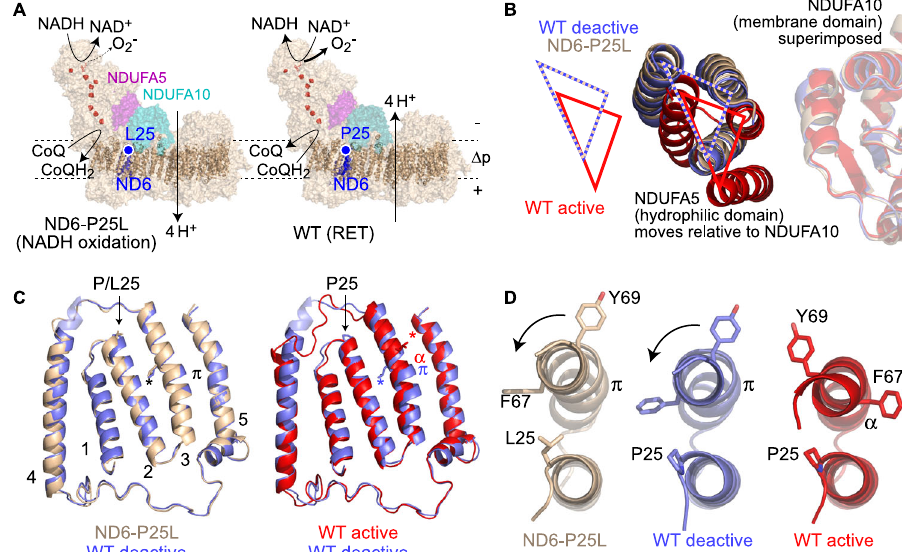
Fig. 1 Structure of complex I containing the ND6-P25L mutation. A The NADH oxidation reaction is shown on the structure of ND6-P25L complex I (left). Complex I oxidizes NADH and reduces CoQ, and pumps four protons out of the mitochondrion to support the proton motive force ( Δ p). The reverse electron transfer (RET) reaction is shown on the structure of WT complex I (right). When Δ p is large and the CoQ pool is highly reduced, electron and proton transfer at complex I are reversed; CoQ is oxidized and NAD + reduced to NADH. Alternatively, the electrons are passed to O 2 to form superoxide (O 2 − ). The site of the mutation and ND6 subunit are shown, along with subunits NDUFA5 and NDUFA10. B The relative orientation of the NDUFA10 and NDUFA5 subunits on the hydrophilic and membrane arms, respectively (see A ), de fi nes ND6-P25L-CI to be in the deactive state. With the three structures superimposed by NDUFA10, the position of the three-helix bundle of NDUFA5 clearly differentiates the active and deactive states. C Comparison of the structures of the ND6 subunit in the WT-D and ND6-P25L complexes (left) and the WT-A and WT-D complexes (right). The gap between the top of TMHs 2 and 3 opens in ND6-P25L relative to WT-D, whereas the π -bulge is present in the WT-D and ND6-P25L complexes but not in WT-A. The asterisks mark the sidechain of ND6-Leu64 to visualize the rotation of the upper part of ND6 TMH3. Structures superimposed on the adjacent ND4L subunit. D Views from above TMHs 2 and 3 showing the rotation in the upper section of TMH3 (carrying Phe67 and Tyr69, top) that must occur to convert the WT-D and ND6-P25L complexes to the active state, and the decreasing (left to right) gap between them. Structures aligned to TMH2 (bottom). See also Supplementary Figs. 1 – 4, and Supplementary Tables 1 and